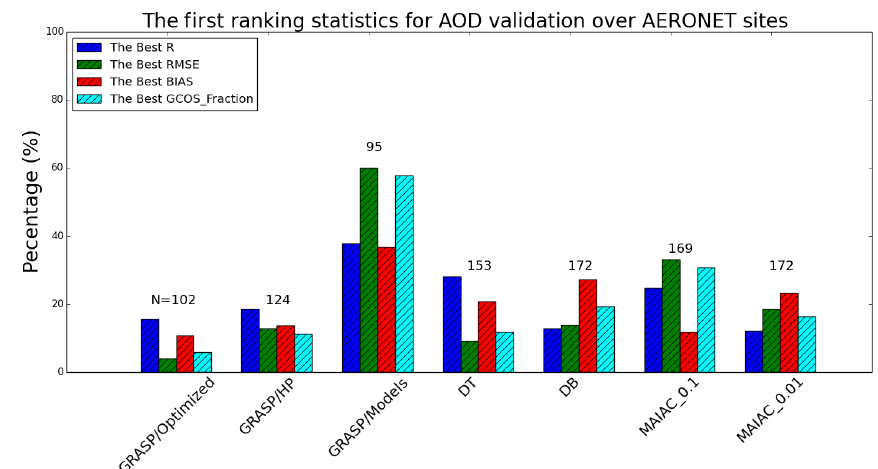
Figure 17. Percentage of the AERONET sites where each product shows the best statistical metric ( R , RMSE, bias and GCOS fraction) between seven PARASOL/GRASP and MODIS AOD products. The number on top of each product is the number of sites where this product has sufficient matchup points for the